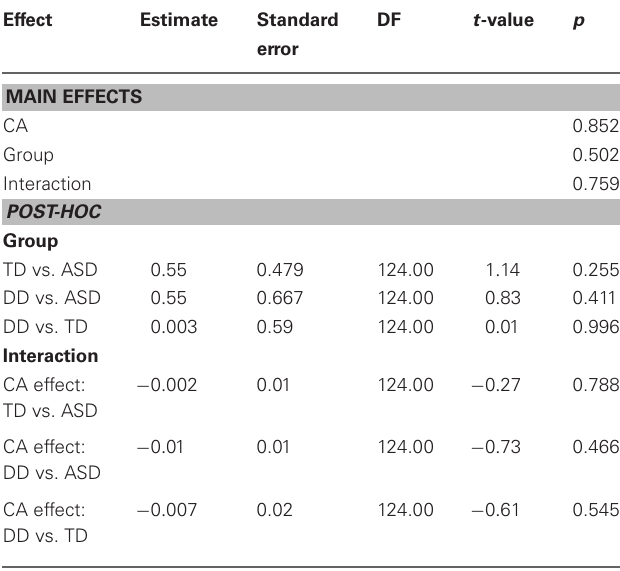
Table 9 | Peak grip force and chronological age